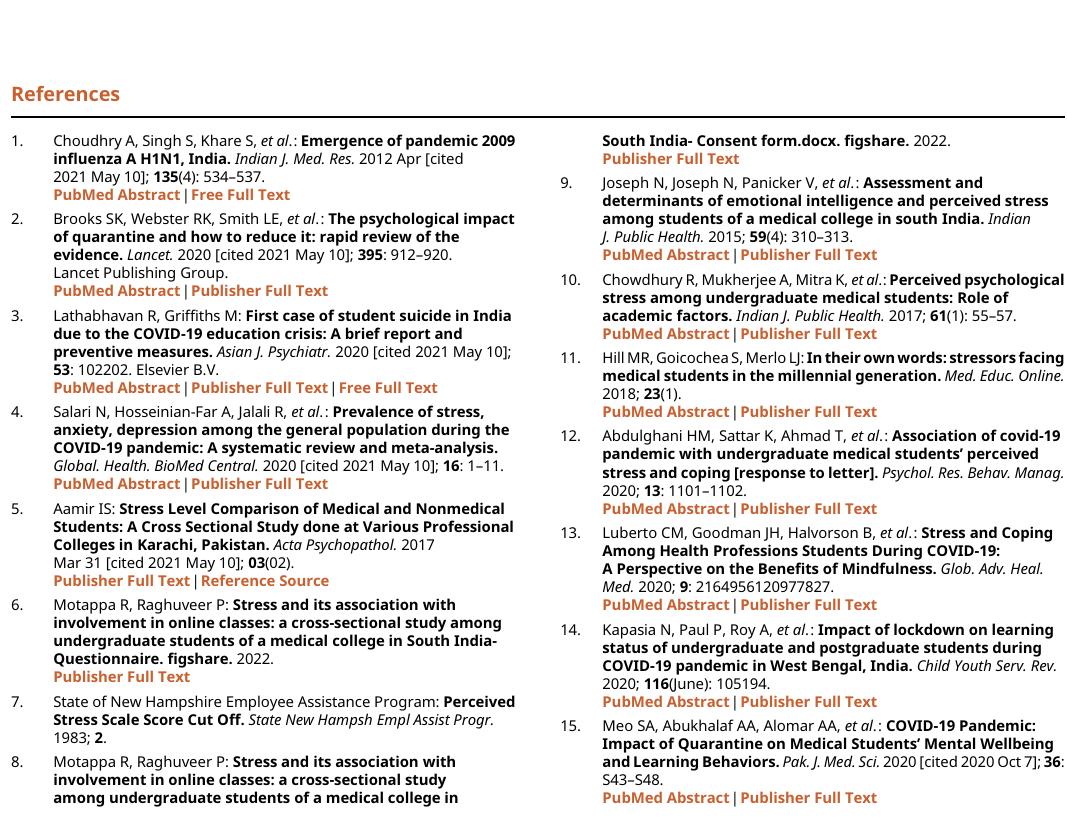
Figshare: Stress and its association with involvement in online classes: a cross-sectional study among undergraduate students of a medical college in South India-Questionnaire. https://doi.org/10.6084/m9.figshare.19431500.v1. 6 This project contains the following extended data: (cid:129) Questionnaire.docx (This is the questionnaire in word format) Figshare: Consent form.docx. https://doi.org/10.6084/m9.figshare.19524058. 18 This project contains the following extended